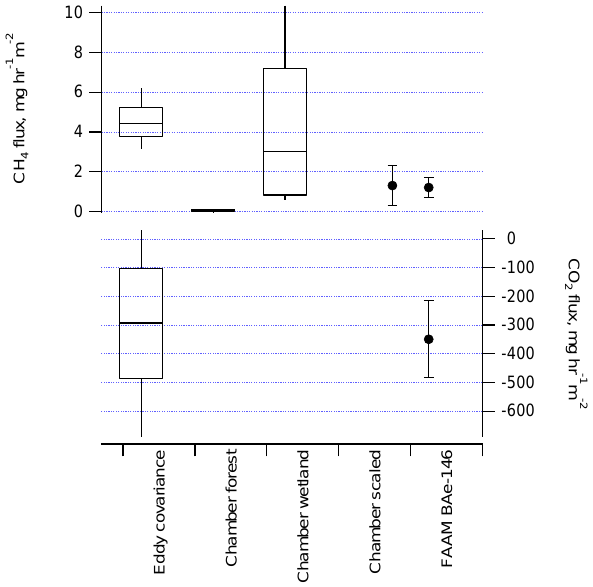
Figure 5. A comparison between different techniques used to de- termine fluxes. The box extents define the 25th and 75th per- centiles, and whiskers are the 10th and 90th percentiles. Note: the eddy covariance percentiles are for daytime (06:00 to 18:00GMT) only. Forest and wetland chamber fluxes represent summer seasonal statistics for 60 chamber measurements (21 in forest regions and 39 in wetland regions). The scaled chamber (black circle) is deter- mined by averaging the wetland and forest chamber fluxes as de- scribed in Sect. 4.3. The FAAM BAe-146 and scaled chamber error bar shows the 1 σ uncertainty as described in Sect.